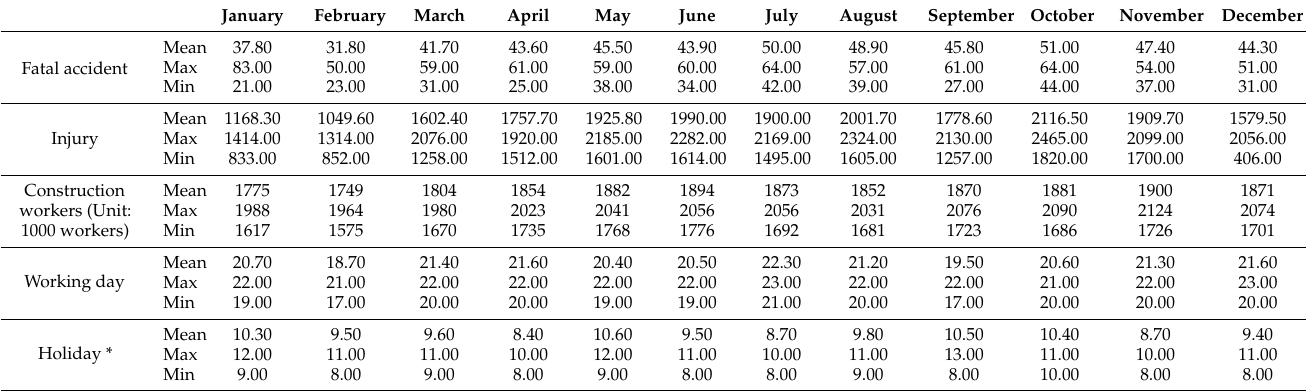
Table 6. Monthly analysis of the number of injury and fatal accidents, construction workers, and working and holiday from 2007 to